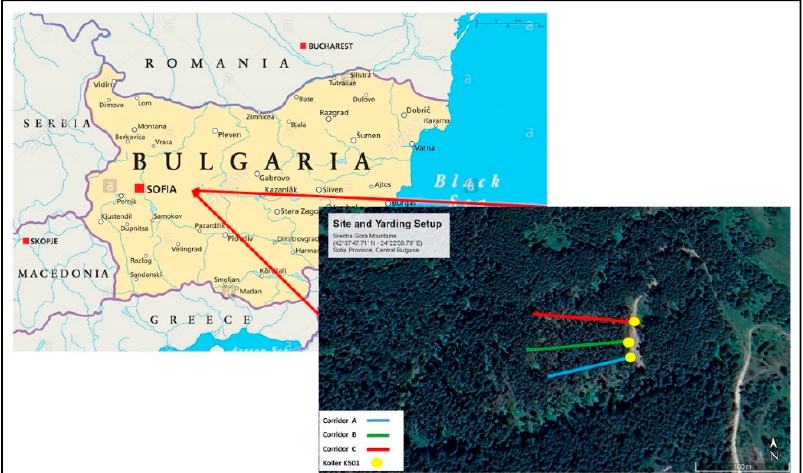
Figure 1. Site map of the study and the schematic layout of the corridors during the cable-yarding operations.